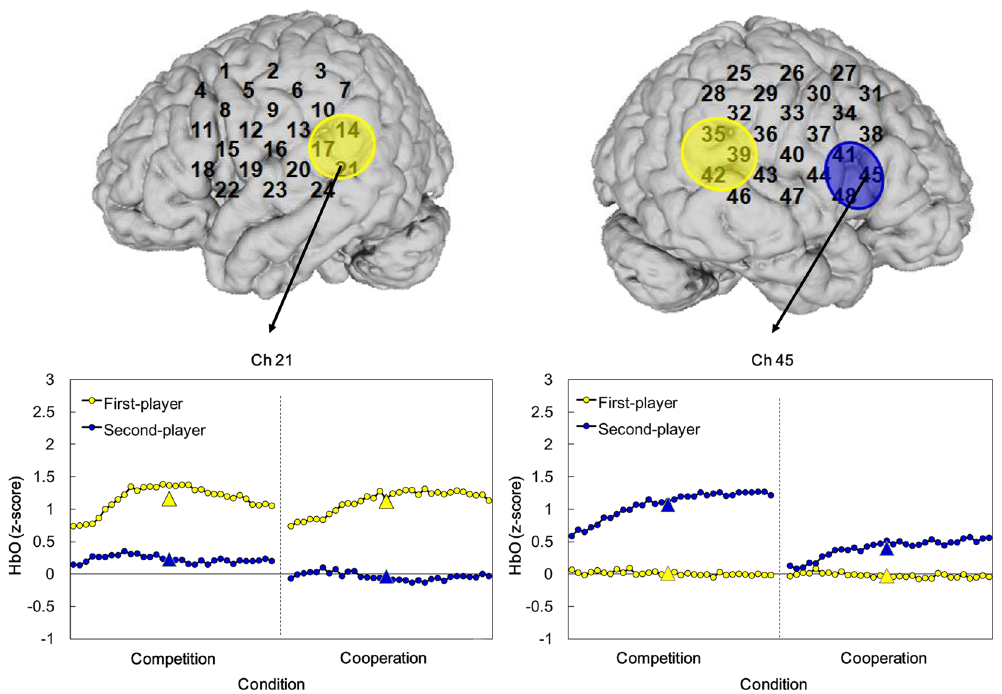
Figure 4. The ROI channels showed statistically significant main effects of role [Yellow (first-player) versus Blue players (second-player)] regardless of the competition and cooperation conditions ( p < 0.001). The yellow and blue triangles represent the mean Oxy of the Yellow and Blue players, respectively. The yellow overlays cover the bilateral pSTS showing higher activations in the first-players than in the second-players, and the blue overlay covers the right IFG, which conversely showed higher activation in the second-players. Two samples of the activation patterns in selected channels are illustrated at the bottom. HbO: concentration changes of oxygenated